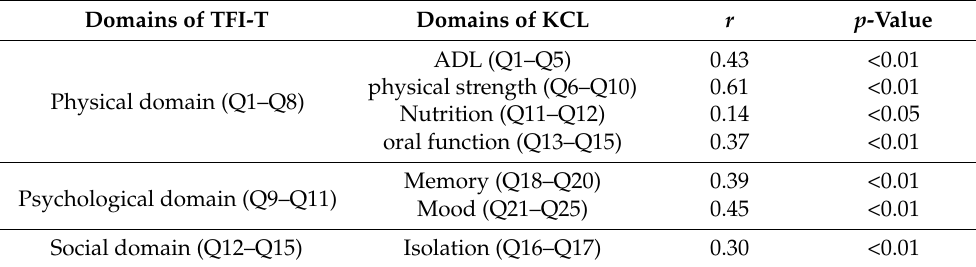
Table 5. Correlation between the TFI-T domains and KCL